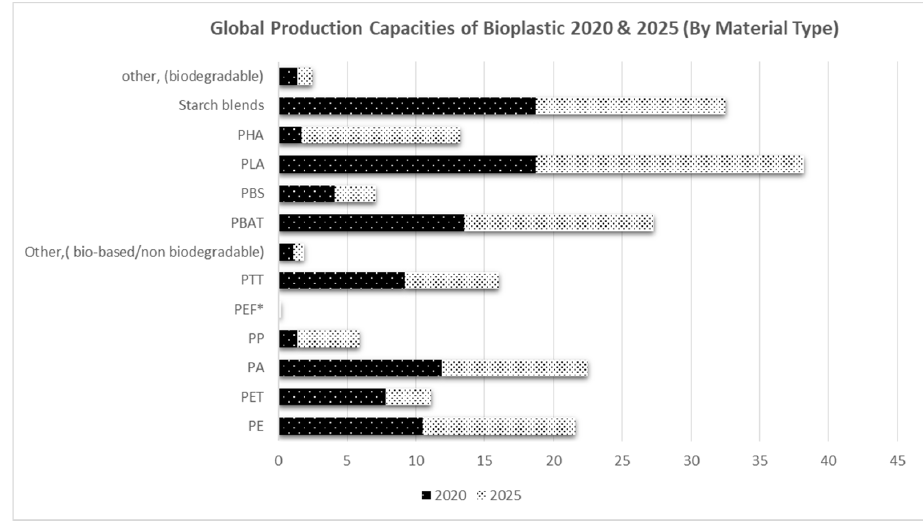
Figure 7. The worldwide production of bioplastic types by material: 2020 and 2025 [72].